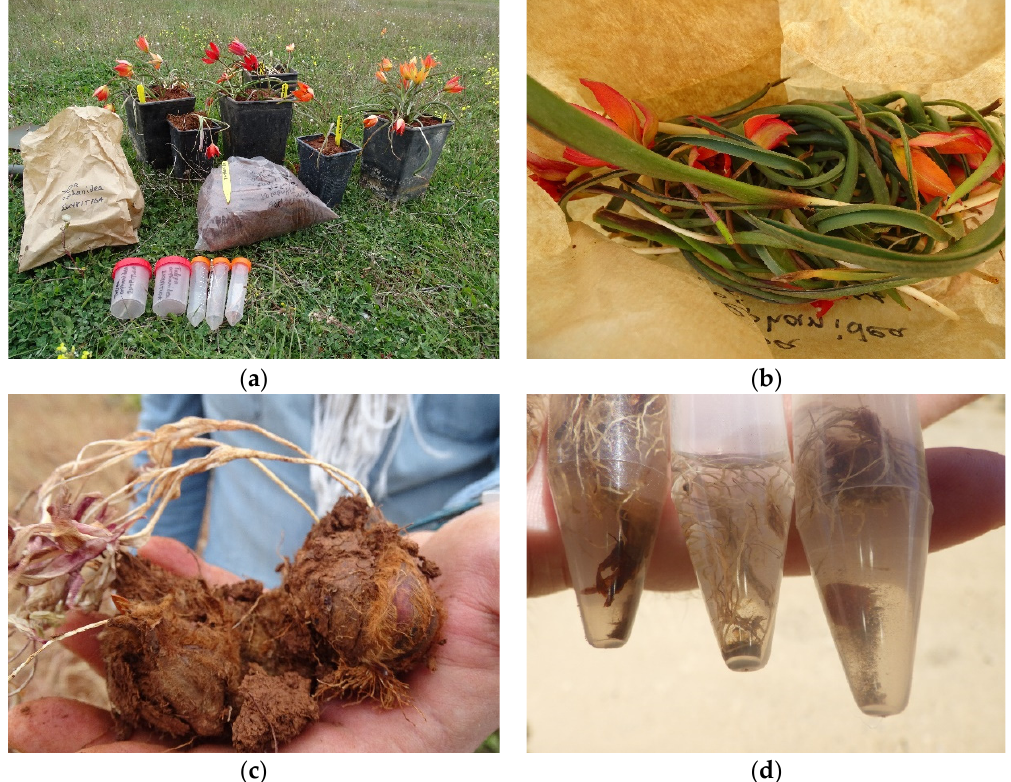
Figure 2. Examples of sampling materials from wild-growing tulip individuals of Greece collected with permission and studied herein: ( a ) propagation materials for ex situ conservation, soil and leaf samples for nutrient diagnostics, and root samples for mycorrhiza analysis collected from Tulipa orphanidea ; ( b ) leaf samples of Tulipa orphanidea ; ( c ) bulb samples of Tulipa goulimyi ; and ( d ) Mycorrhiza samples from different individuals of Tulipa bakeri.